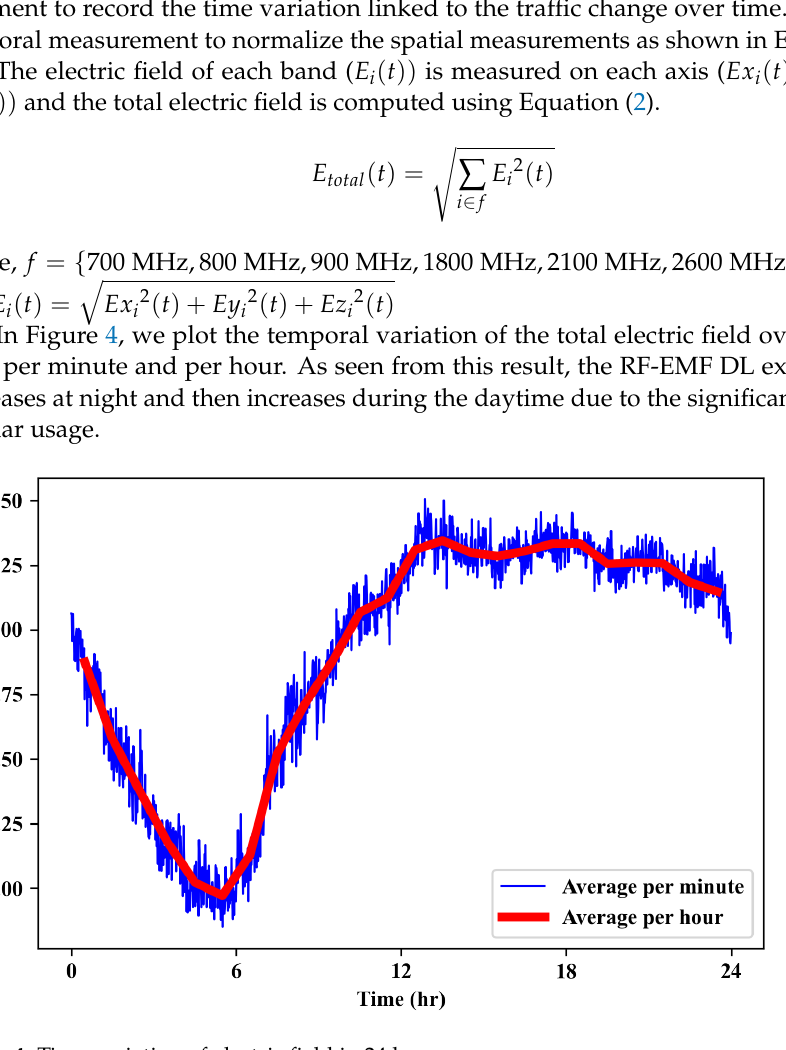
Figure 4. Time variation of electric field in 24